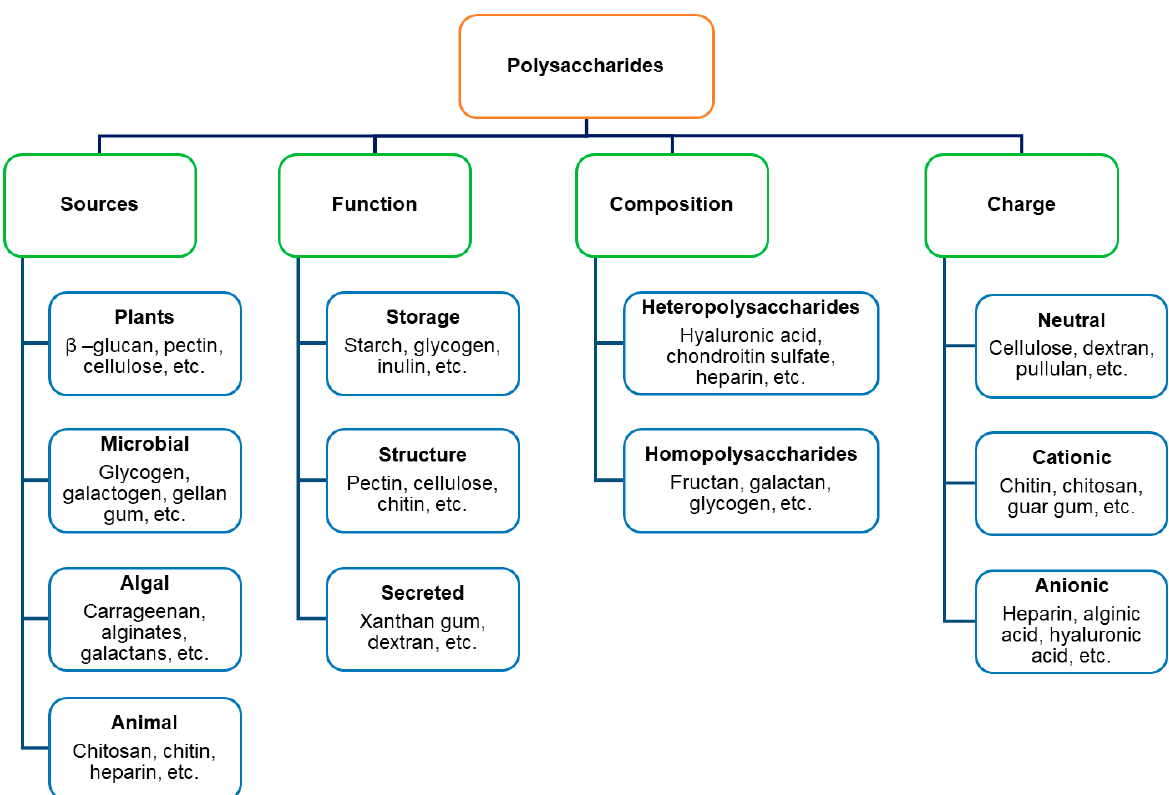
Figure 1. Classifications of polysaccharides.